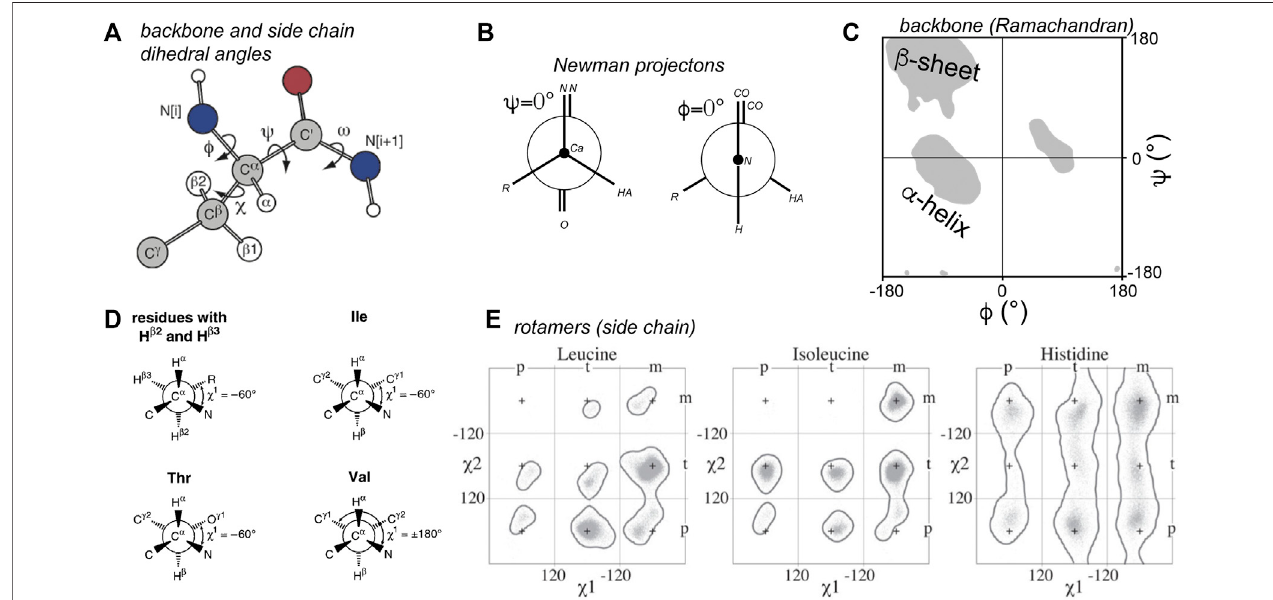
FIGURE1| Torsionanglesinproteins. (A) Dihedralanglesde fi ningtheproteinbackboneandsidechain: ϕ , ψ ,and ω ,and χ . (B) Newmanprojectionsofthe ϕ and ψ angles. The zero degree con fi guration of each is shown. (C) Ramachandran plot of ϕ and ψ angles. Grey areas indicate the classic secondary structure regions that are mostpopulated.Notethatthe ϕ (cid:1) 0 ° from panelBisnotusuallyobservedduetosterichindrance. (D) De fi nitionsofthe χ 1 sidechainangle. (E) Rotamerstatesfor χ 1 and χ 2 forthreeresiduetypes.PanelAisadaptedwithpermissionfrom(Hongetal.,1997a), (D) isadaptedwithpermissionfrom(Markleyetal.,1998),andpanelEfrom (Hintze et al.,